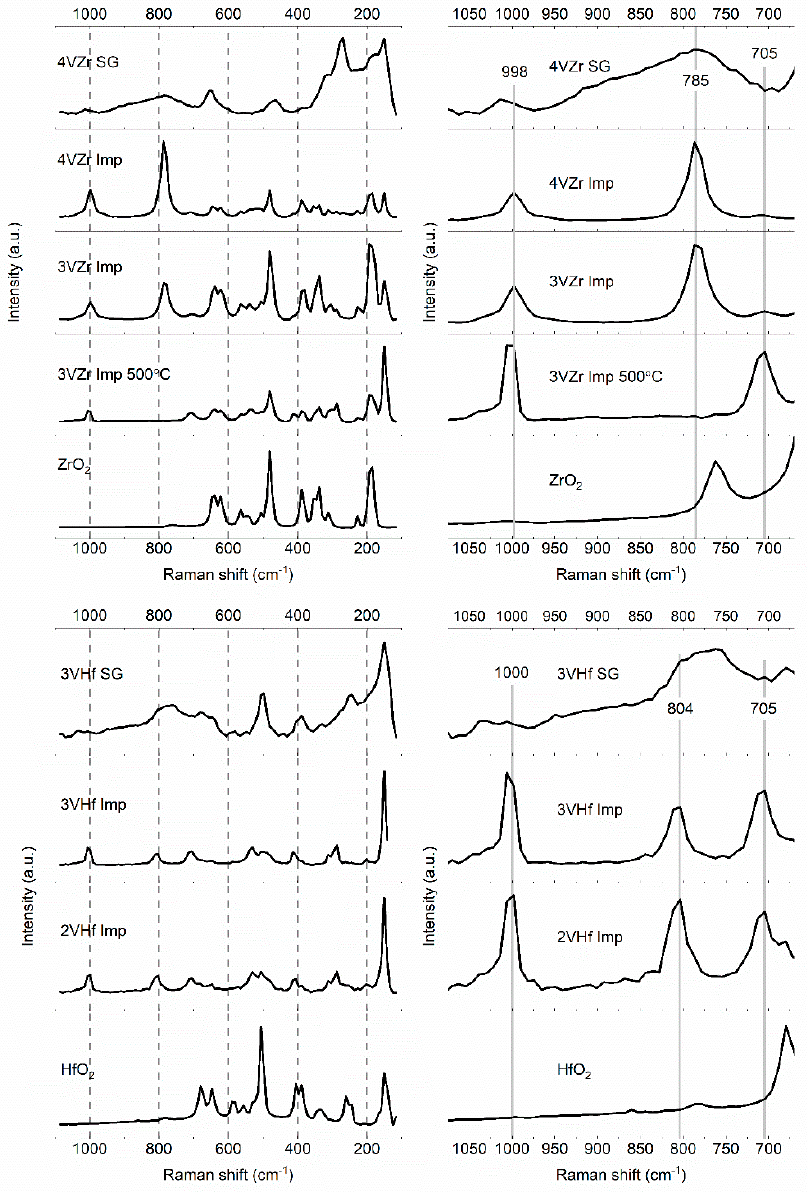
Figure 4. Raman spectra of ZrO 2 , HfO 2 , and prepared catalysts.